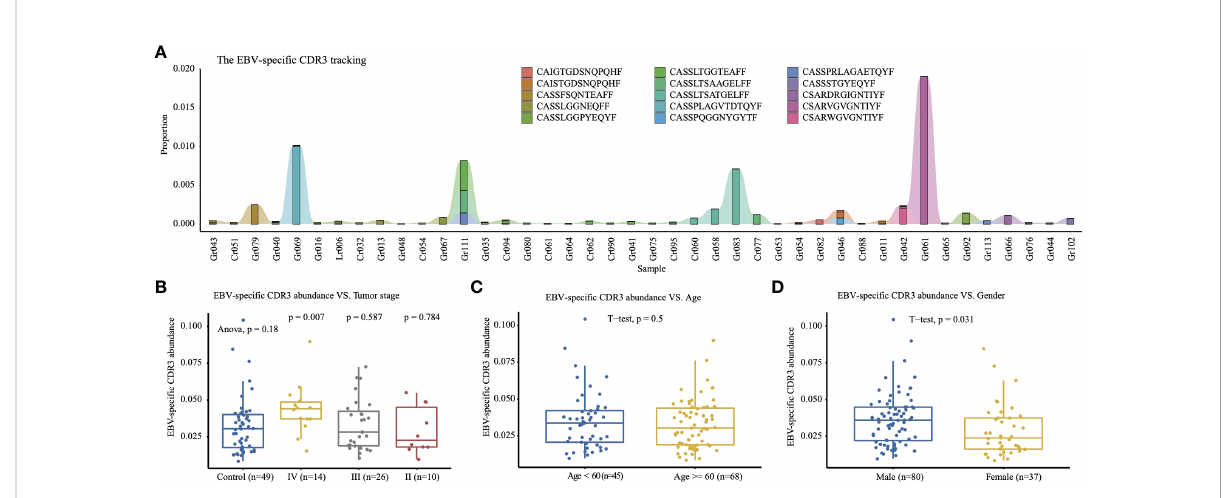
FIGURE 4 Top 15 EBV-speci fi c CDR3. (A) Tracking the top 15 high-frequency EBV-speci fi c CDR3 that have higher abundance in the tumor group; samples with a total count of EBV-speci fi c CDR3 of less than 2,000 are excluded. The y -axis is the proportion of each CDR3 among the repertoire. The EBV-speci fi c CDR3 abundance comparison of tumor stages (B) , age (C) , and gender (D) among 117